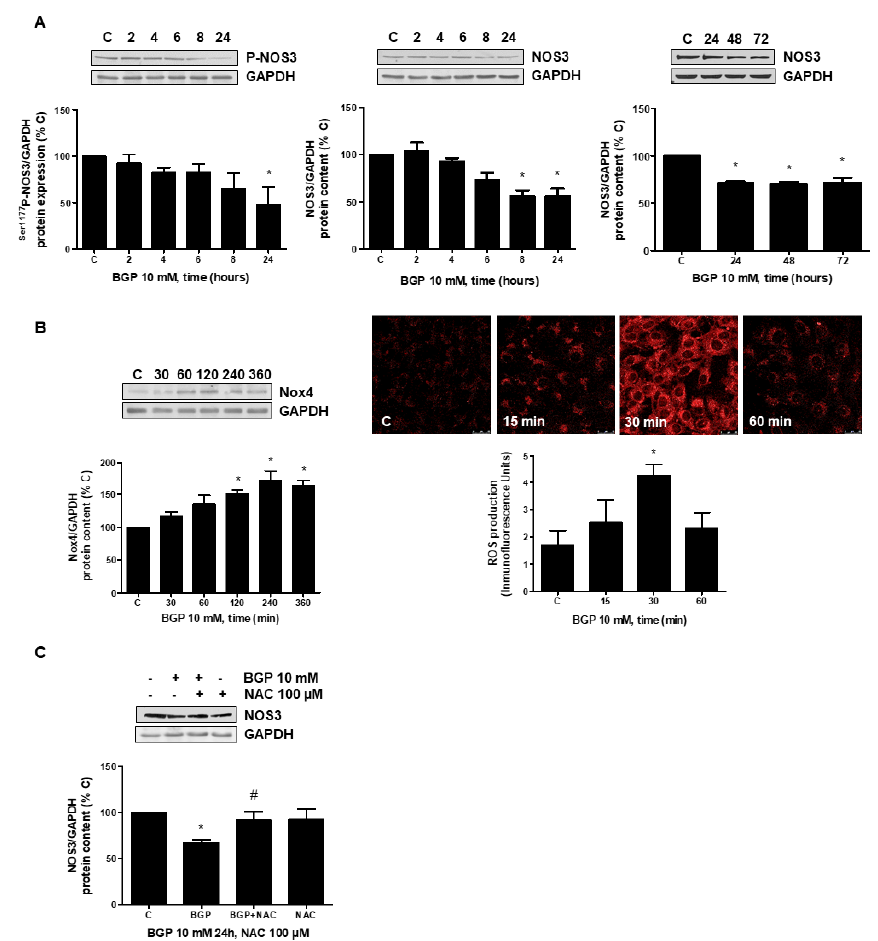
Figure 5. BGP-induced downregulation of NOS3 depends on ROS production in human endothelial cells. A human endothelial cell line (EA.hy926) was treated with 10 mM BGP at different time points ( A , B ). Some cells were incubated in the presence of 100 µM N-acetylcysteine (NAC), and then BGP was added for 24 h ( C ). ( A ) NOS3 activity and NOS3 expression were studied by the expression of Ser1177 P-NOS3 and NOS3, respectively, in human endothelial cells treated with 10 mM BGP at different times. ( B ) Oxidative stress was analyzed by Nox4 expression by Western blot (on the left panel) and by ROS production using a CellROX probe that was added during the last 30 min of incubation. ROS production in red fluorescence were visualized by confocal microscopy, representative microphotographs are shown on the right panel with 40 x magnification, scale bar and 50 µm, and the densitometric analysis is shown below. ( C ) Endothelial cells were preincubated with 100 µM NAC before adding BGP for 24 h, and then NOS3 expression was evaluated by Western blot. A representative Western blot is included at the top of each panel with the densito- metric analysis below. Values are the mean ± SEM of 5 ( A , B ) or 4 ( C ) independent experiments, * p < 0.05 vs. control cells ( C ) and # p < 0.05 vs. BGP alone.